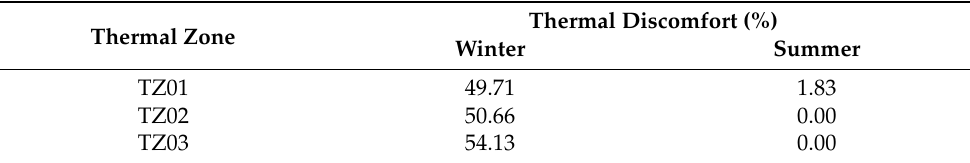
Table 7. Thermal discomfort—Scenario B.